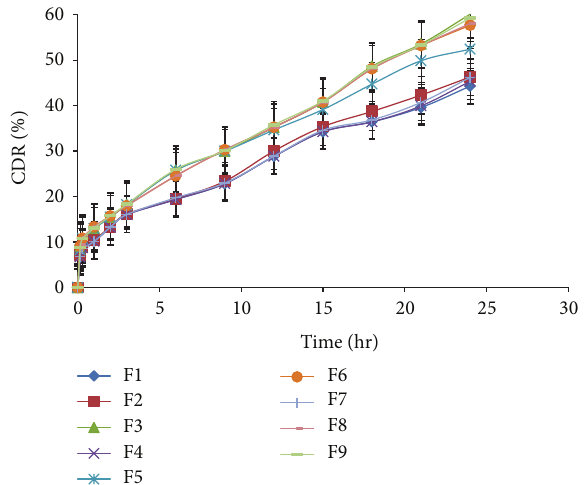
Figure 7: In vitro permeation profile of CsA-NPs of all nine batches.